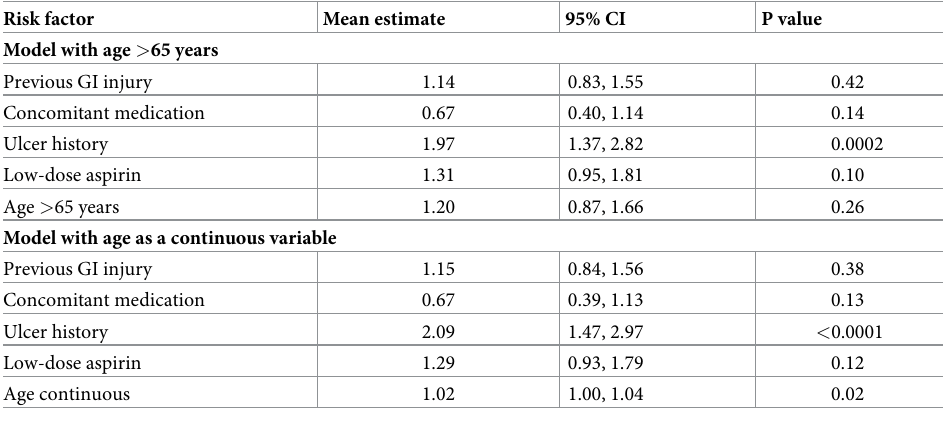
Table 4. Relative risk models including all five high risk